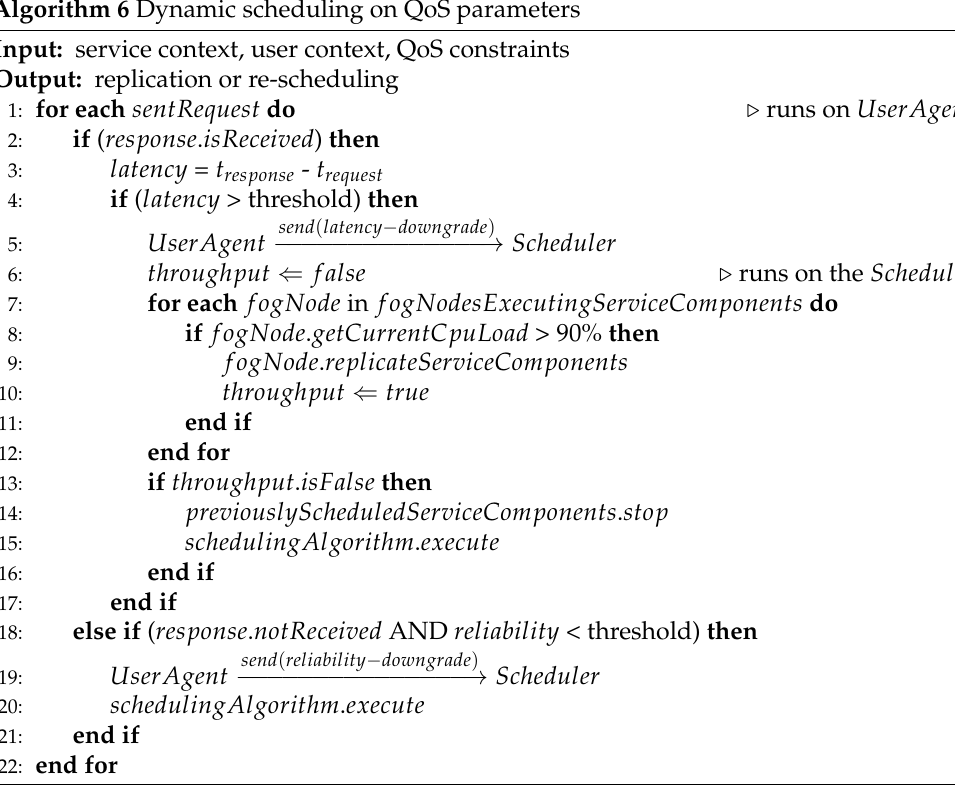
Algorithm 6 Dynamic scheduling on QoS